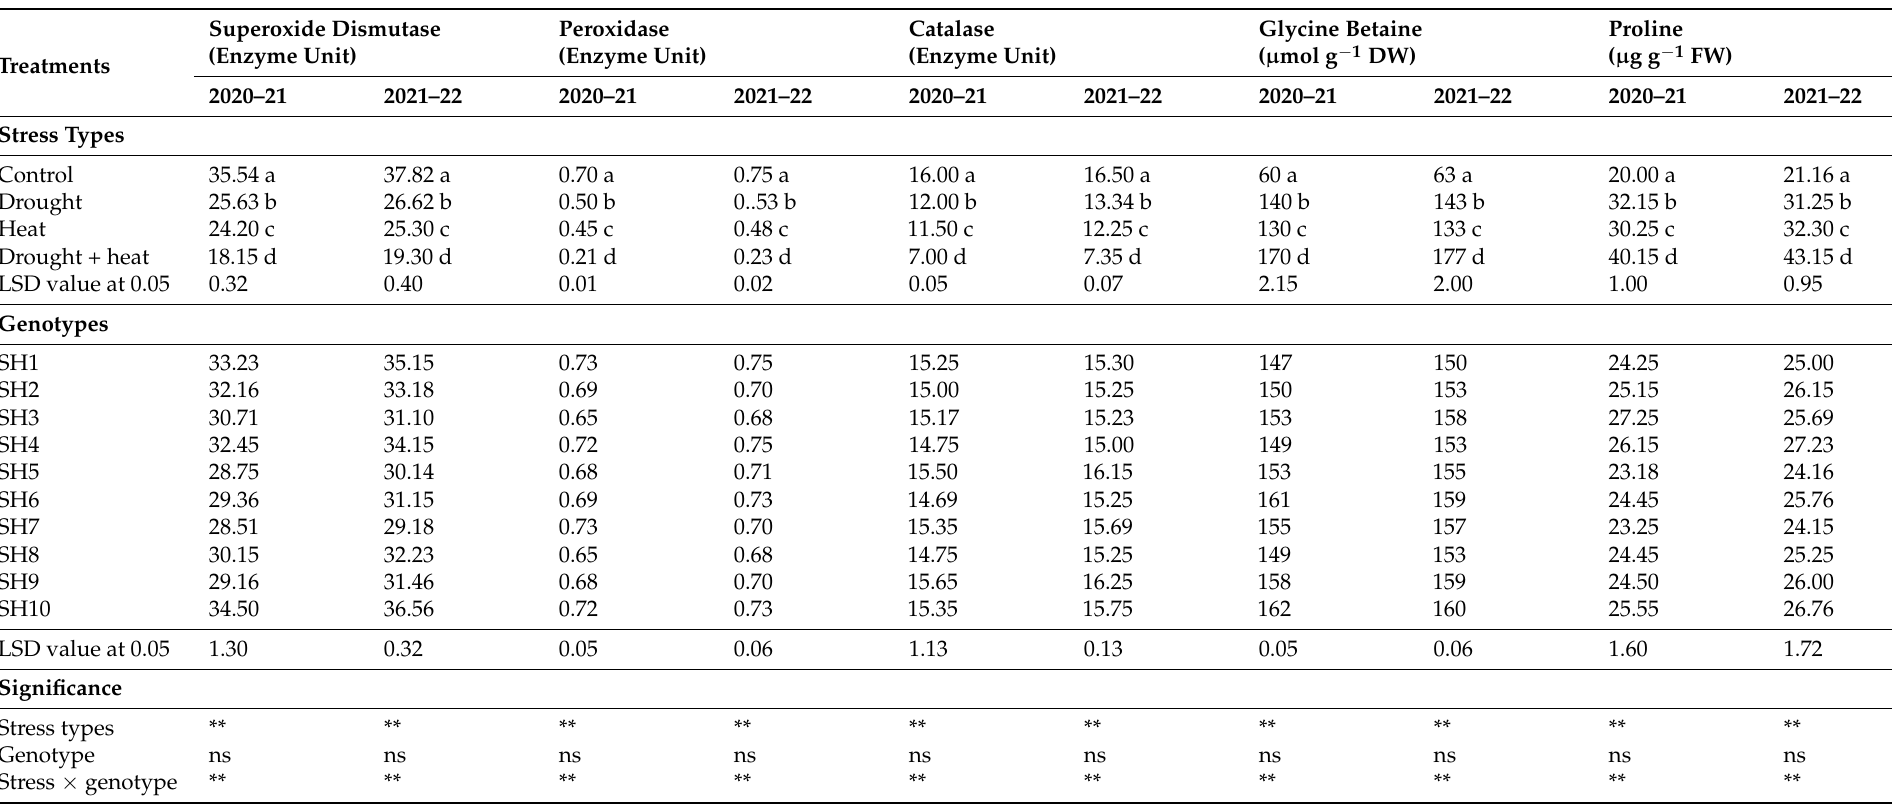
Table 4. Variation in biochemical parameters of different synthetic hexaploid wheat genotypes due to individual and combined application of drought and